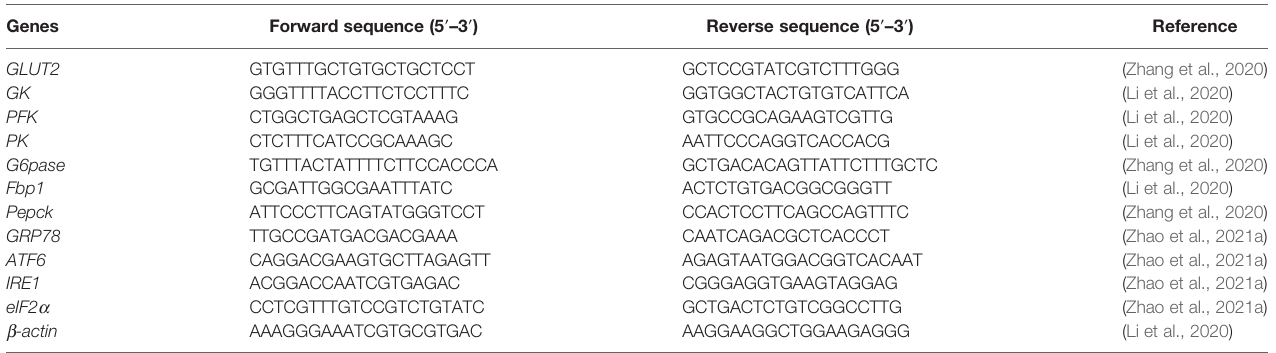
TABLE 2 | Primer sequences.